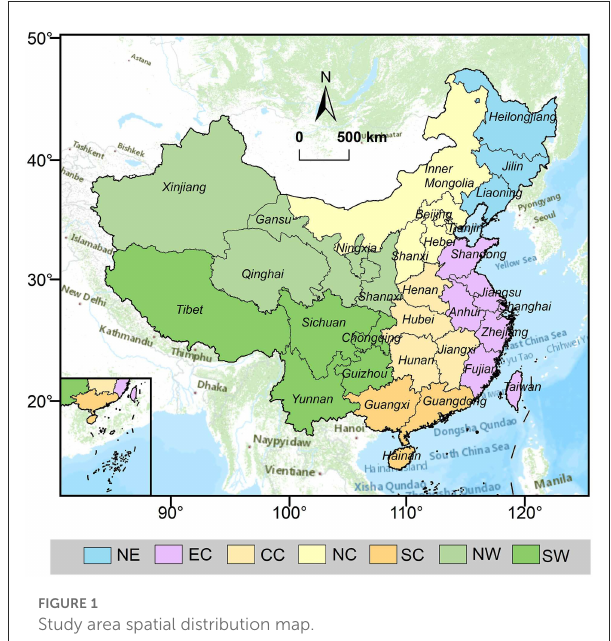
FIGURE1 Study area spatial distribution